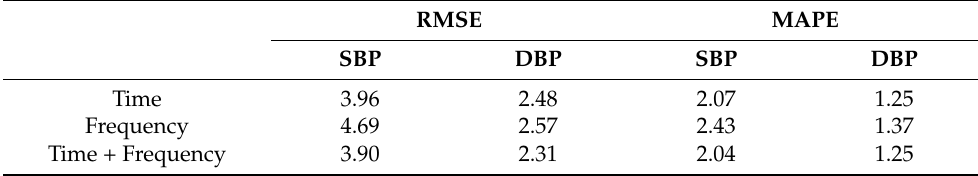
Table 3. Experimental results of input signals represented in time or frequency domain.